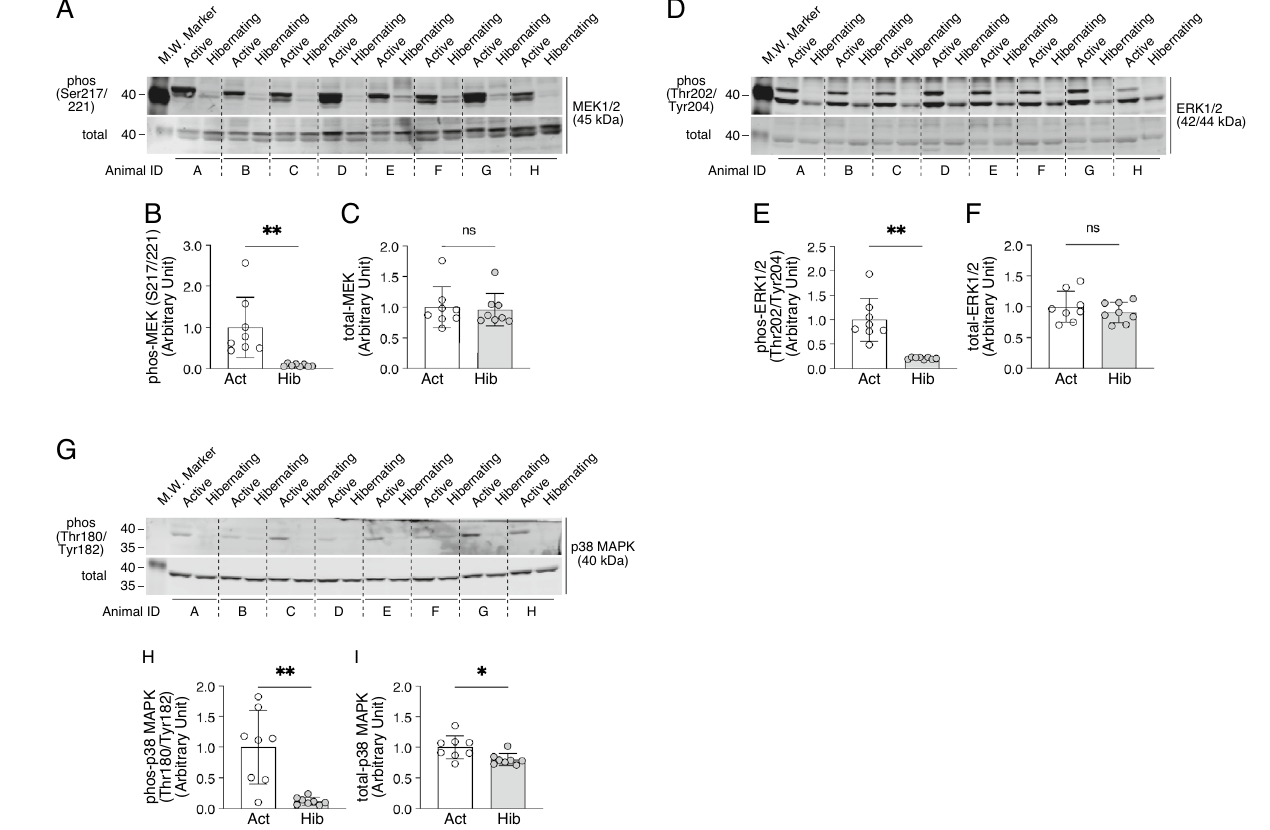
Figure 3. Alterations in the phosphorylation status of MAPK-dependent signaling in bear skeletal muscles during hibernation. Typical western blotting images of signaling molecules involved in MAPK-dependent signaling and their quantification results are presented. ( A – C ) phosphorylated (Ser217/221) and total expression of MEK1/2. ( D – F ) phosphorylated (Thr202/Tyr204) and total expression of ERK1/2. ( G – I ) phosphorylated (Thr180/Tyr182) and total expression of p38 MAPK. n = 8 in each group. All results are expressed as mean ± standard deviation (SD). Significant differences: *p < 0.05, **p < 0.01 between active versus hibernation total rpS6 protein) was increased, the signaling inputs that positively regulate muscle protein synthesis and cell growth were significantly suppressed in the skeletal muscle of bears during hibernation. Alteration in the regulatory system for muscle protein catabolism during hibernation. AMP- activated protein kinase (AMPK), a cellular energy sensor, is activated by increased ADP or AMP concentrations which are associated with ATP hydrolysis and it maintains energy homeostasis by suppressing mitochondrial energy production and promotes the catabolic pathway to generate ATP. As hibernation is considered to be a prolonged period of fasting and energy deprivation, we first expected that AMPK phosphorylation status in skeletal muscles would be elevated during hibernation. However, the reality was the opposite: total expres- sion and phosphorylation of AMPK were significantly suppressed during hibernation in bear skeletal muscles (Fig. 4). This probably indicates that the muscles, during hibernation, are in an energy-saving state, in which ATP hydrolysis is not actively occurring. Since AMPK is known to negatively regulate the mTORC1 signaling pathway through TSC complex subunit 2 (TSC2) or regulatory associated protein of MTOR, complex 1 (Rap- tor), alterations in TSC2 phosphorylation during hibernation were also examined (phosphorylation of Raptor was also attempted, but could not be detected in bear skeletal muscle samples). We did not observe significant alterations in phosphorylation status and total protein expression of TSC2 in both active and hibernation peri- ods, suggesting that the decreased phosphorylation of AMPK was not causing a compensatory activation of the mTORC1 pathway during hibernation in bear skeletal muscles. In addition, the gene expression level of myostatin, a well-known negative regulator of skeletal muscle growth, was determined, and we did not observe any significant alterations during hibernation (Fig. 5A). Further, the expression levels of each gene, which is generally enhanced during skeletal muscle atrophy, in the proteolytic system were determined (Fig. 5B–F). Atrogin1 and Murf1, skeletal muscle-specific E3 ubiquitin ligases, also known as markers of muscle atrophy, showed significantly decreased gene expression levels in skeletal muscles during hibernation. Gene expression levels of autophagy-related factors including Atg7, Becn1, and Map1lc3, were also significantly down-regulated during hibernation. From these results, it is possible to speculate that the